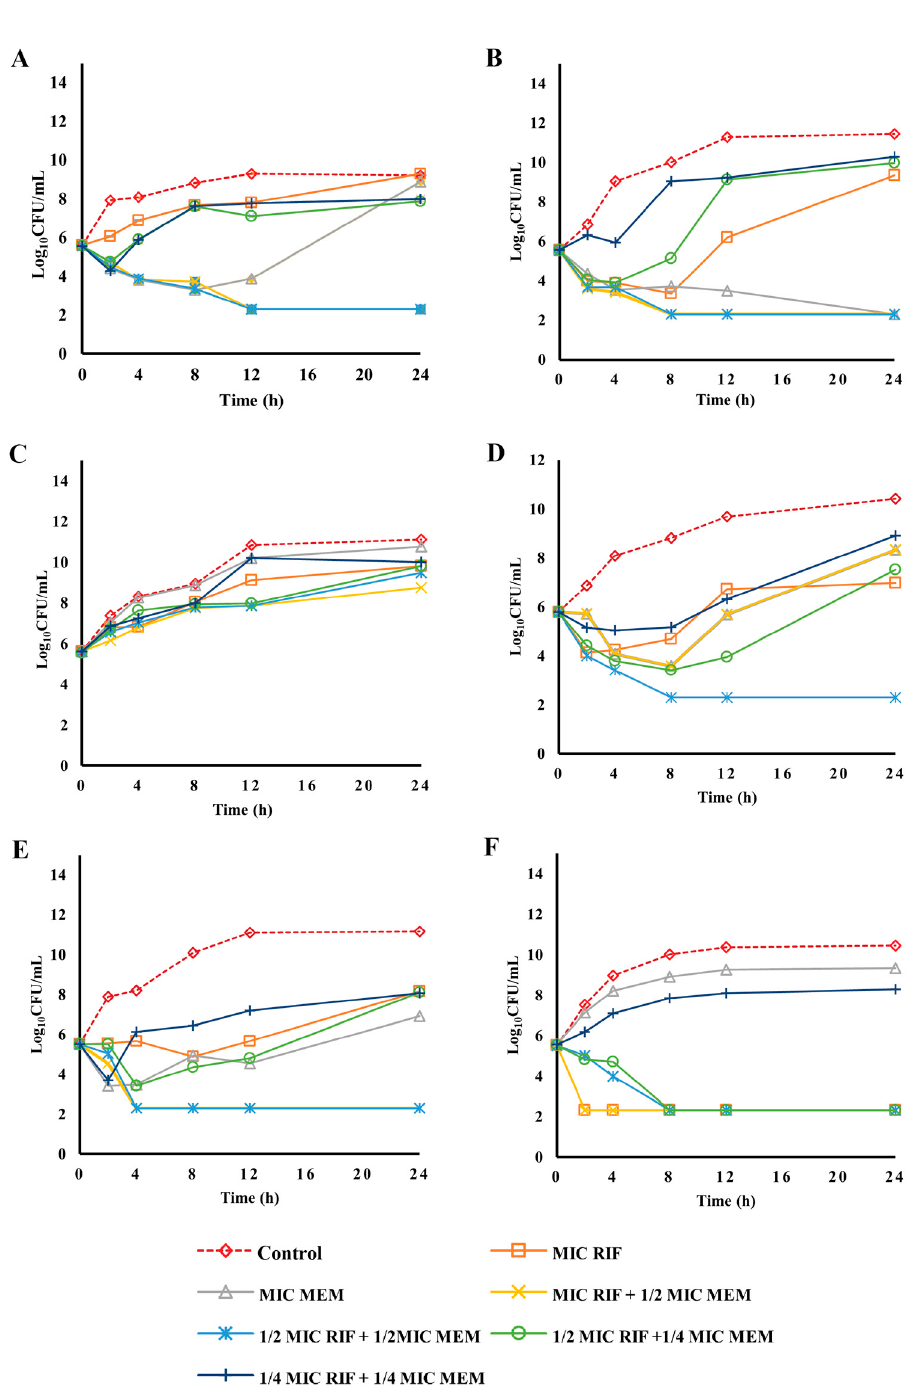
Figure 1. Time-kill kinetic of rifampicin and combination with meropenem against rifampicin-resistant and carbapenem-resistant clinical isolates of A. baumannii . SK015 ( A ), TR069 ( B ), and ST004 ( C ) are isolates with high rifampicin MIC ( ≥ 16 µg/mL), while TR131 ( D ), TR123 I ( E ), and TR057 ( F ) are isolates with lower rifampicin MIC ( ≤ 8 µg/mL). Experiments were performed in duplicate. MIC, minimum inhibitory concentration; RIF, rifampicin; MEM, meropenem.